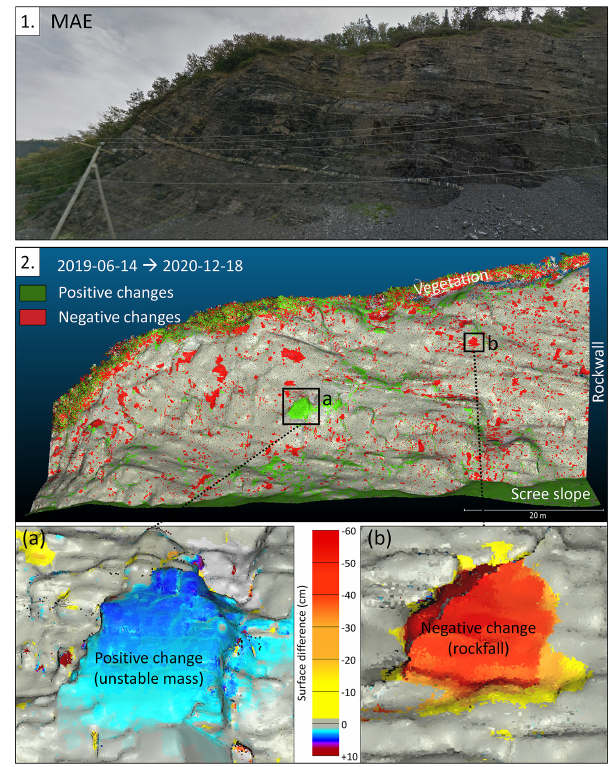
Figure 4. Point clouds of main changes (MAE rockwall) between the first (14 June 2019) and last (18 December 2020) scan surveys. Positive changes are mainly relative to unstable rock mass (a) , and negative changes highlight rockfall (b)